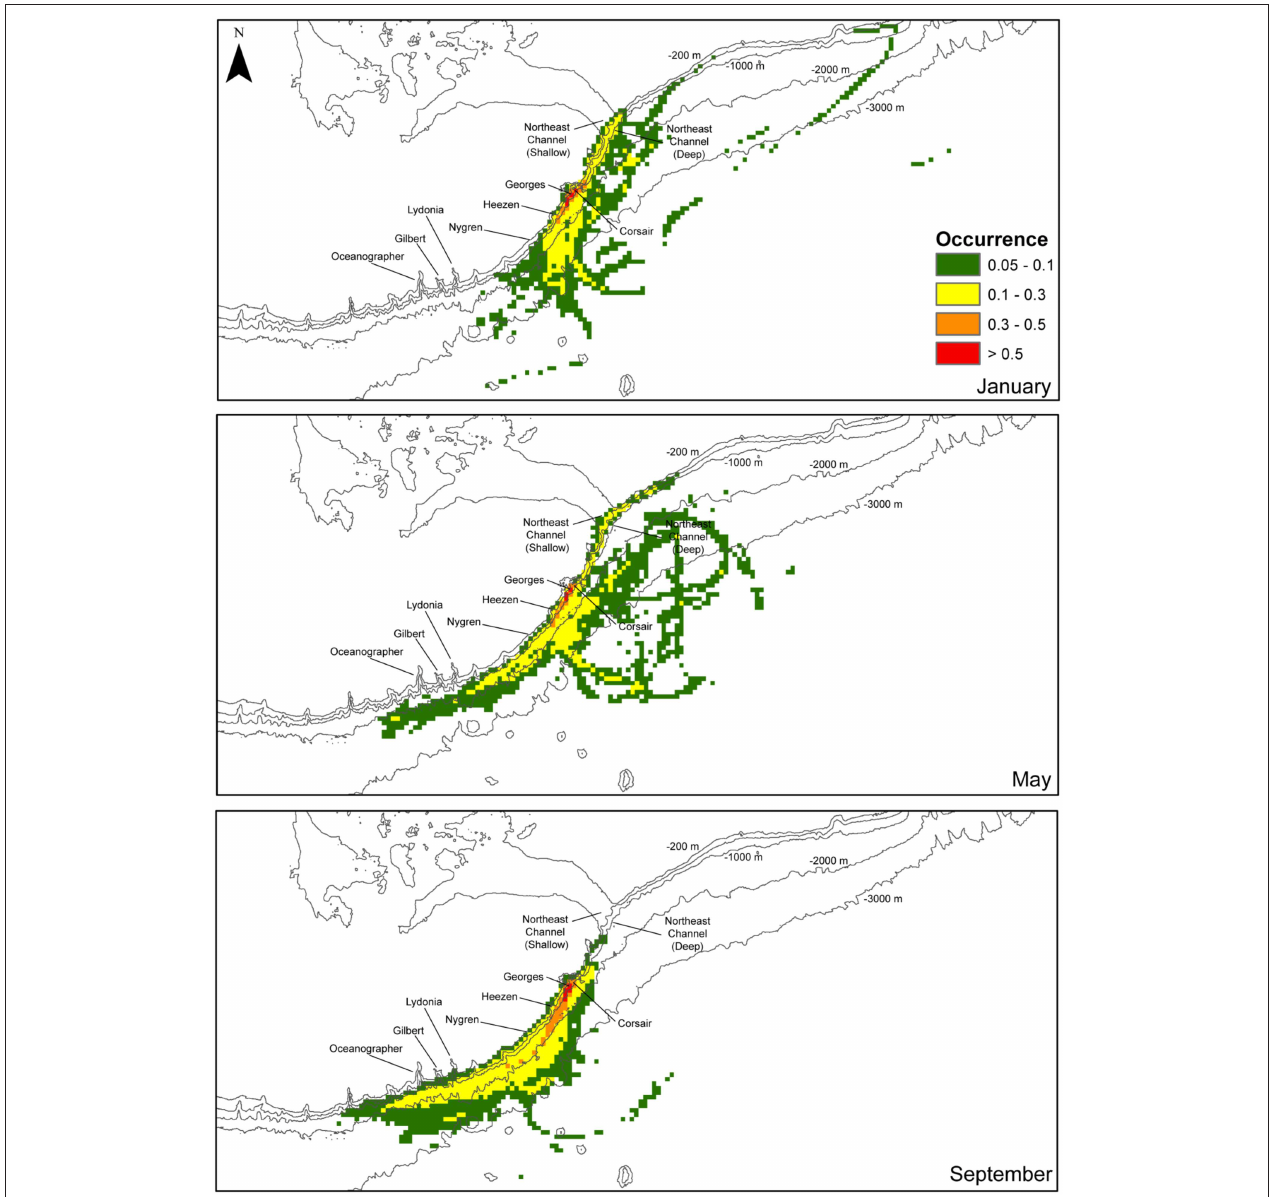
FIGURE 11 | Fraction of the total number of tracks (0–1) of all tracks in the region surrounding the mouth of Corsair Canyon over the maximum temporal length of release (60 d) segregated by month: January, May, and September (total of 750 tracks for each month). Densities were computed on a 5km x 5km grid. Fractions below 0.05 are not